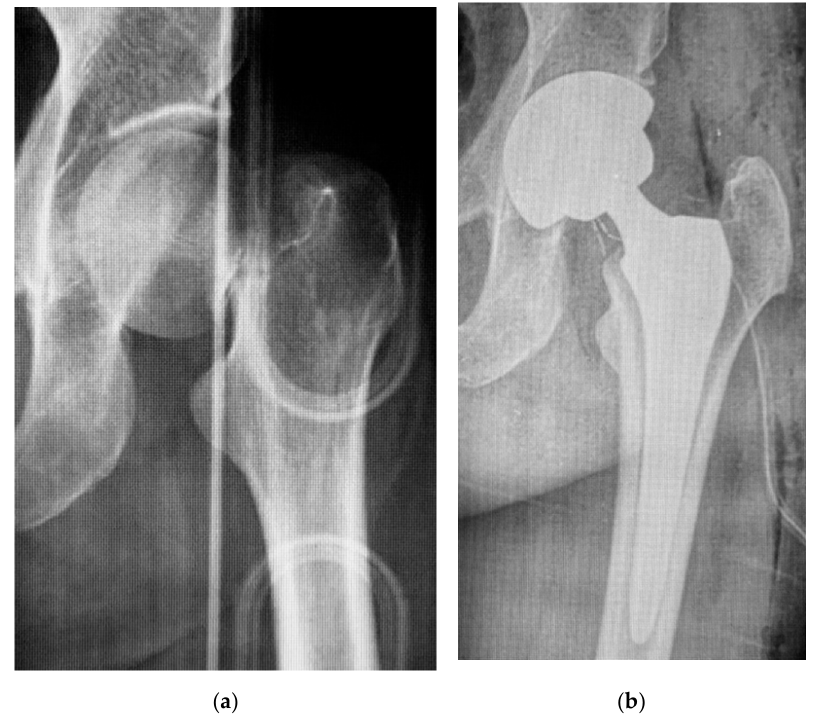
Figure 3. Male, 42 years old, displaced fracture of his left femoral neck: preoperative AP X-ray of the involved hip ( a ), and immediate postoperative X-ray ( b ) of the AMC-on-AMC THA with a 36 mm head and a stem with a modular